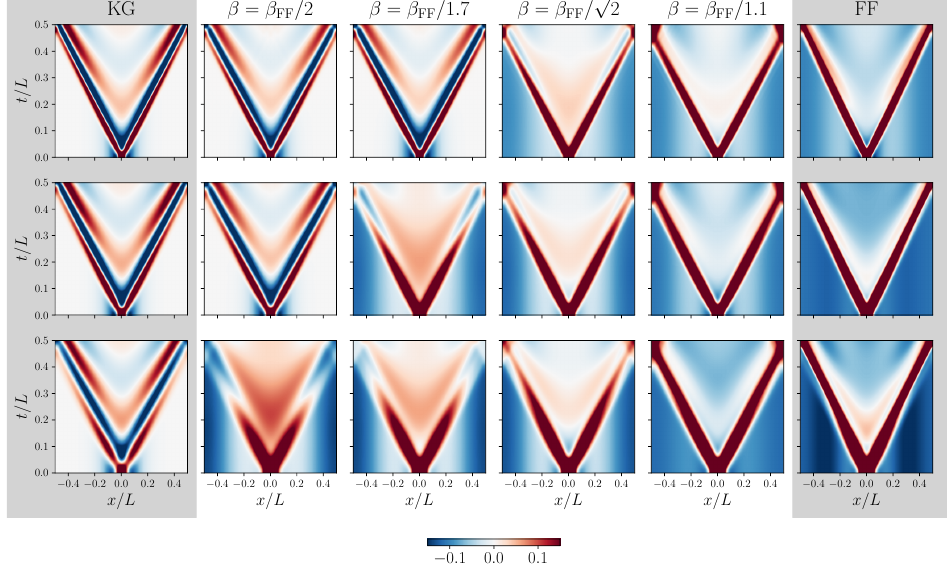
Figure 1.1: Transition from free boson-like to free fermion-like behaviour after an inhomogeneous quantum quench in the sine–Gordon model: Density plots of ϕ ( x , t ) / ( 2 π ) as a function of the time evolution of the soliton density ρ ( x , t ) = β∂ x the space and time coordinates x , t at various values of the parameters. From left to (cid:112) = right the sine–Gordon coupling β changes from 0 (Klein–Gordon limit) to β 4 π FF (free fermion point), while from top to bottom the initial external field bump changes from shorter and thinner to taller and wider bumps (the three rows correspond to / m σ taking the bump height parameter A β and the Gaussian width parameter m FF 1 1 the values ( 12,1 / 3 ) , ( 15,4 / 9 ) and ( 18,2 / 3 ) , respectively). In the Klein-Gordon case ϕ ( x , t ) / ( 2 π ) would lead to zero result, so instead ( β = 0) the relation ρ ( x , t ) = β∂ (cid:112) x ϕ ( x , t ) / ( 2 π ) which is the same relation which was used we defined ρ ( x , t ) = ∂ x / 2, to facilitate comparison. Note the change in the at the next coupling β = β FF propagation fronts from having oscillatory tails (Klein–Gordon dynamics) to fast de- caying tails (free fermion dynamics). In addition, the background is neutral (white) in the free boson limit, while at the free fermion point a negatively charged (blue) background appears to compensate for the positive (red) bump charge. This change is triggered by a crossover transition in the initial state, which occurs at an interme- diate value of β which depends on the initial bump